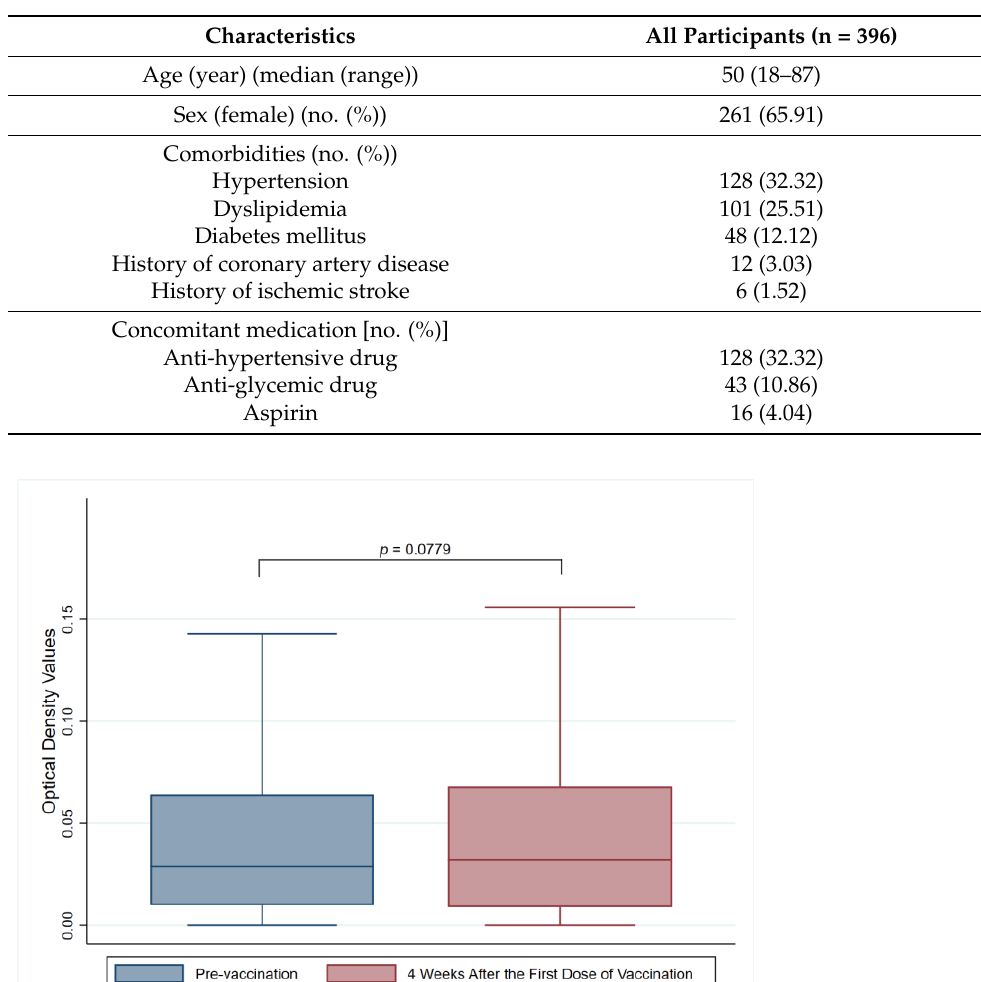
Figure 1. Cohort flow diagram of the study. Table 1. Demographic data and clinical characteristics of participants.